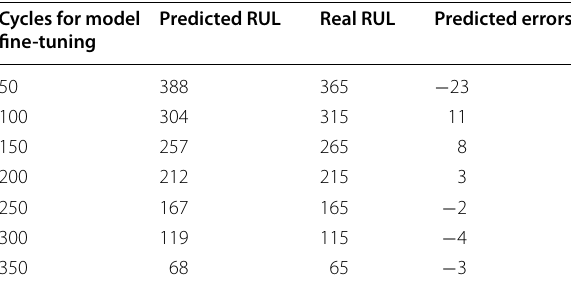
Table 2 Lifetime prognostic errors for the battery pack Cycles for model